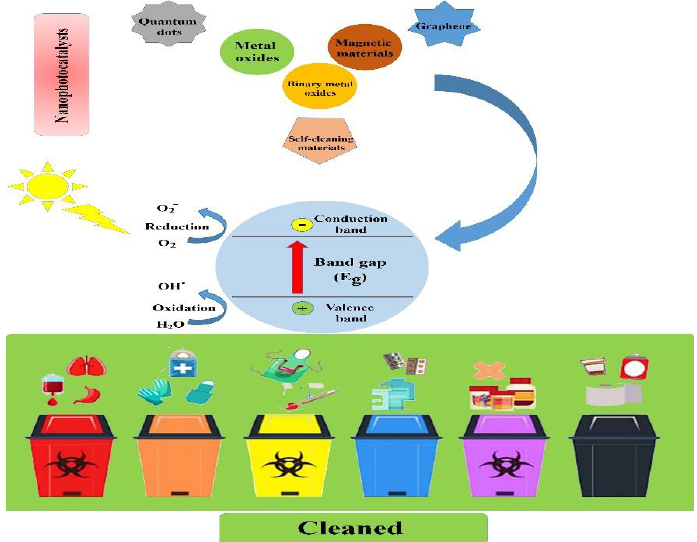
Figure 1. Schematic illustration showing the main types of nanophotocatalysts and the process by which biomedical and biological waste materials are cleaned.